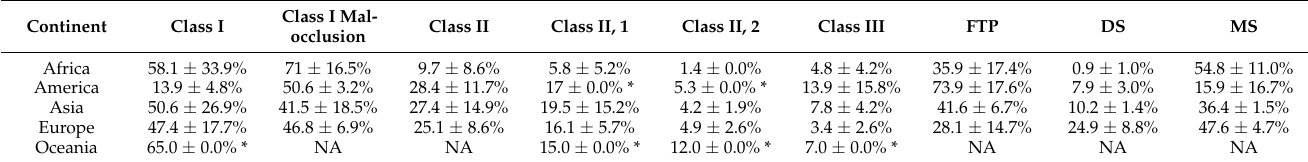
Table 4. Prevalence of angle classification and deciduous molar occlusion according to geographi- cal location.